Question: Author a descriptive caption for the visualization shown.
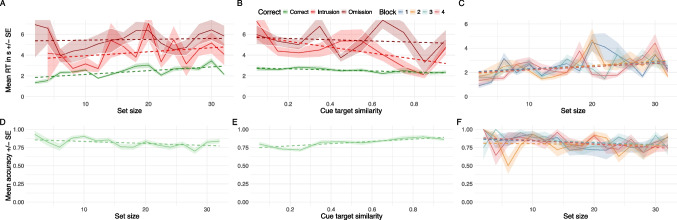
Answer: Results Experiment 1. A , B , and C The mean RTs (solid lines) and regressions (dotted lines) of the RTs. The shaded are represents the standard error. A and C The RTs across set sizes. In A , the colors represent the correctness of the response. In C , the colors represent the different blocks. Here, only correct responses are plotted. D , E , and F The same, but for accuracy. All shaded areas around the mean represent the standard error (SE) of the mean